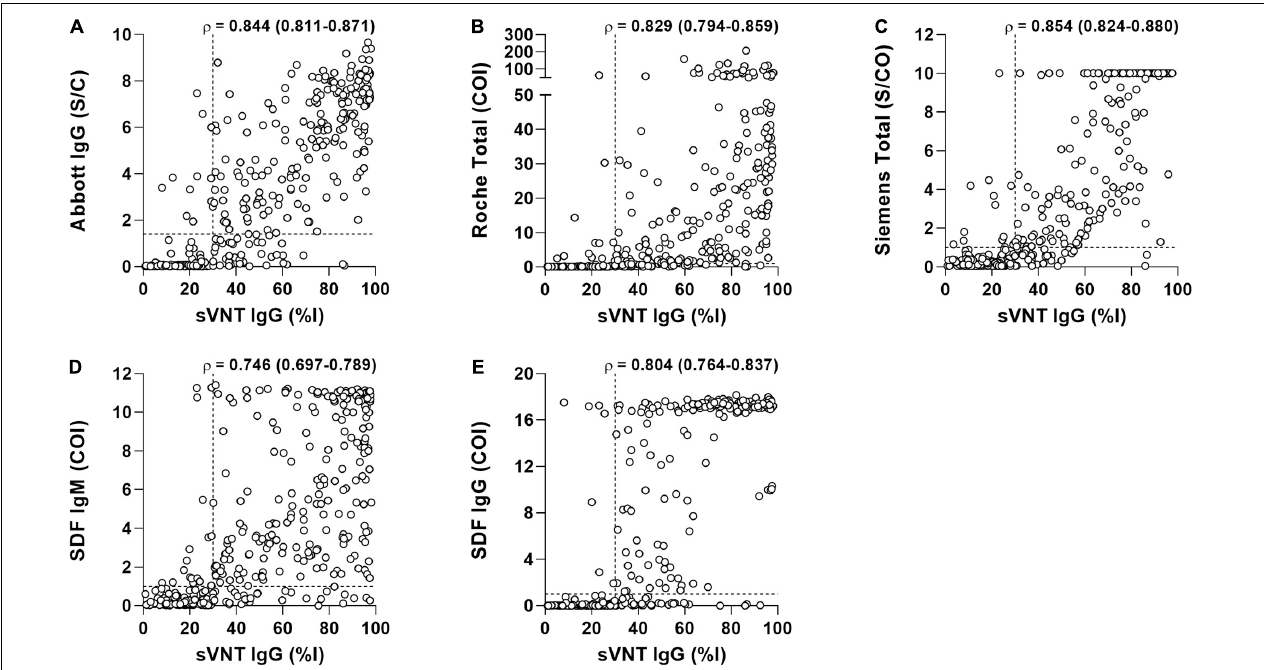
FIGURE 3 | The correlation of surrogate virus neutralization test (sVNT) with the binding antibody assays in 389 samples from 199 COVID-19 patients. (A) Abbott vs. sVNT. (B) Roche vs. Siemens. (C) Siemens vs. sVNT. (D) SDF IgM vs. sVNT. (E) SDF IgG vs. sVNT. Each triangle represents an individual positive sample. Correlation between two measures was performed using Spearman ρ (95% confidence interval). The horizontal and vertical dotted lines indicate the cut-off value of each assay. Abbott, SARS-CoV-2 IgG (Abbott); COI, cut-off index; %I, percentage inhibition; Roche, Elecsys Anti-SARS-CoV-2 (Roche); S/C, sample/calibrator; S/CO, sample/cut-off; SDF, STANDARD F COVID-19 IgM/IgG Combo FIA (SD BIOSENSOR); Siemens, ADVIA Centaur SARS-CoV-2 Total (Siemens); sVNT, surrogate virus neutralization